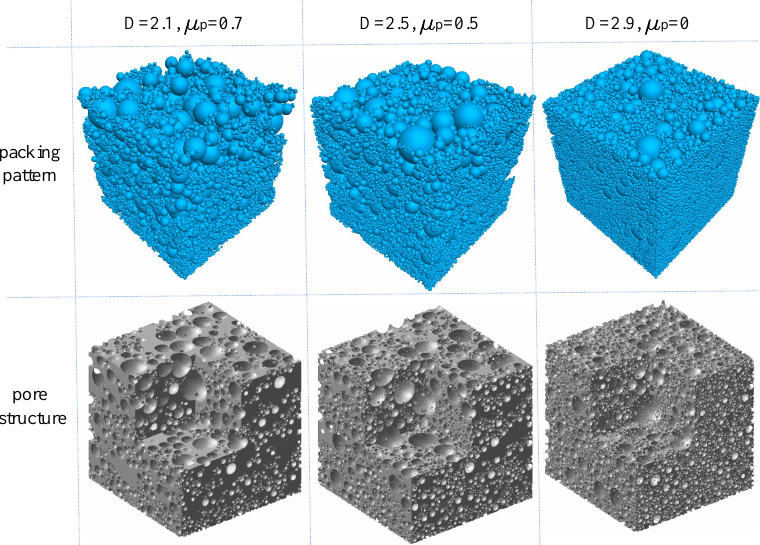
Figure 9. Packing patterns and pore structures of three typical